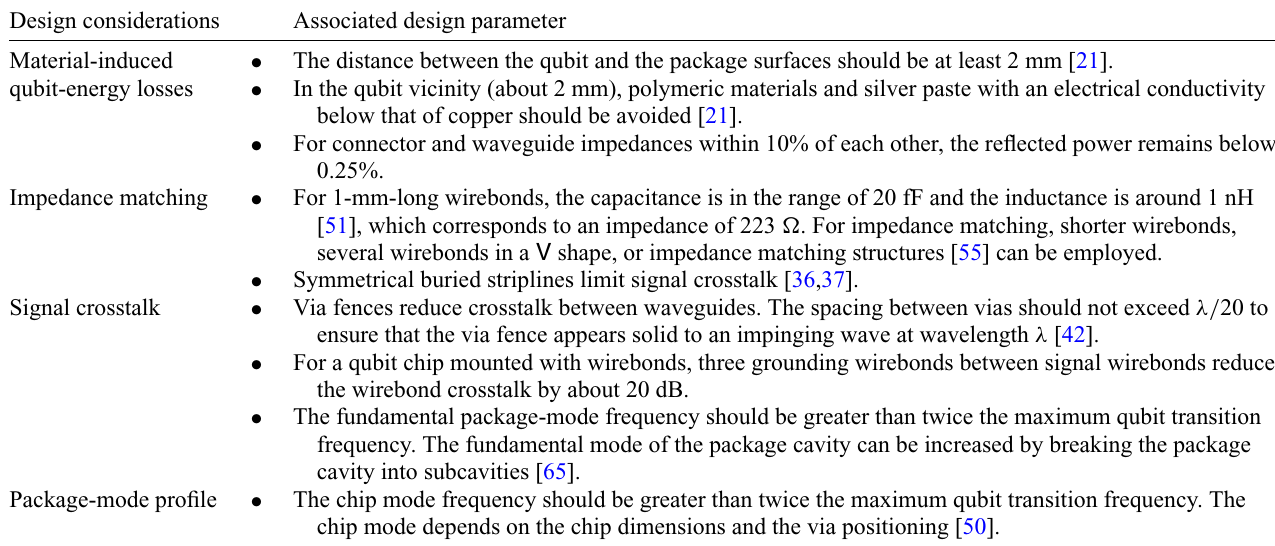
TABLE III. Package design considerations with a focus on qubit-energy-loss channels, impedance matching, signal crosstalk, and package-mode profile.